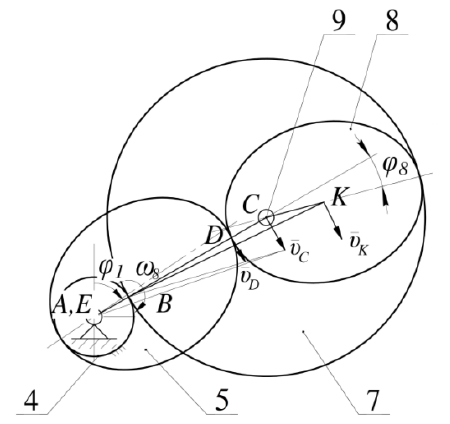
Figure 4. Scheme for determining the velocities V C and V K